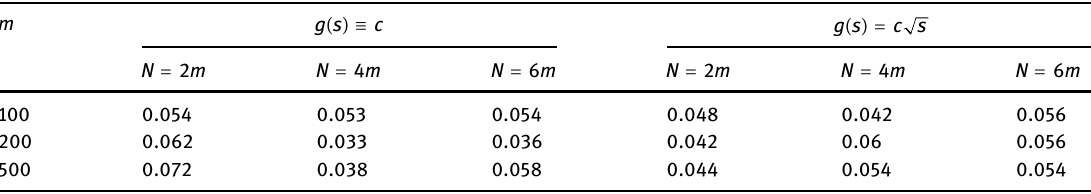
Table 1: Empirical sizes of tests based on ( ) m k Γˆ , for the 5% signi fi cance